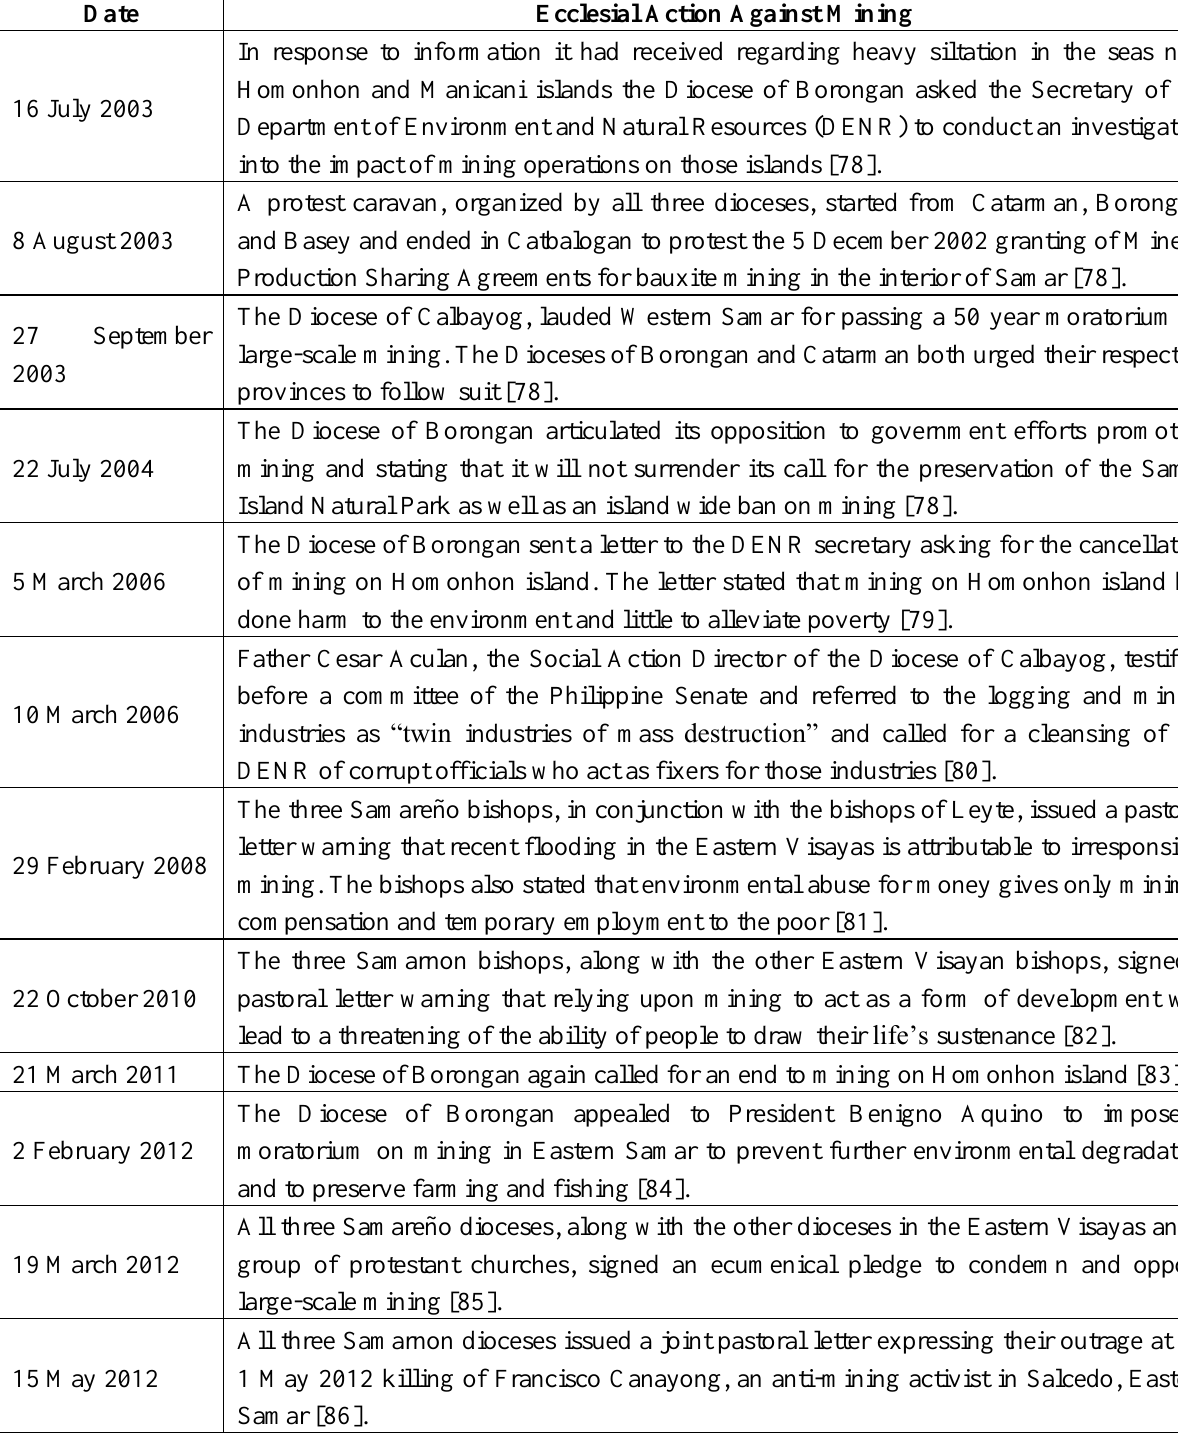
Table 2. Examples of Ecclesial Activism against Mining on